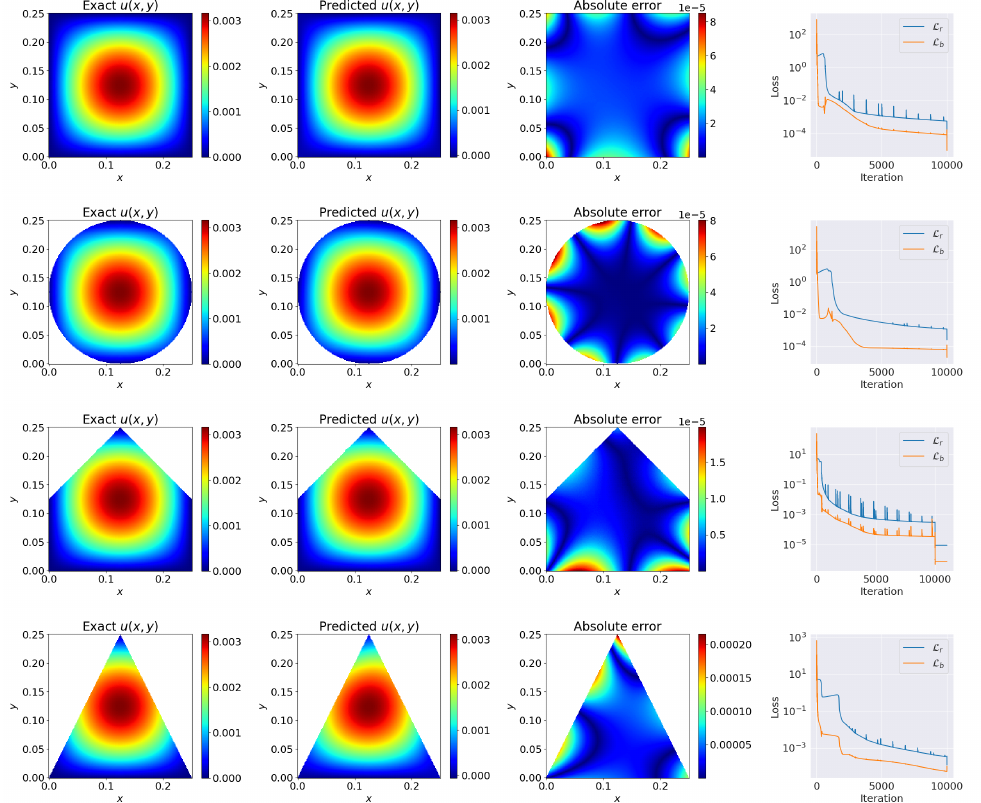
Figure 7. cSPINNs results (with ResNet block-enhanced modified neural network) for solving the 2D Poisson equation with an exact solution u ( x , y ) =